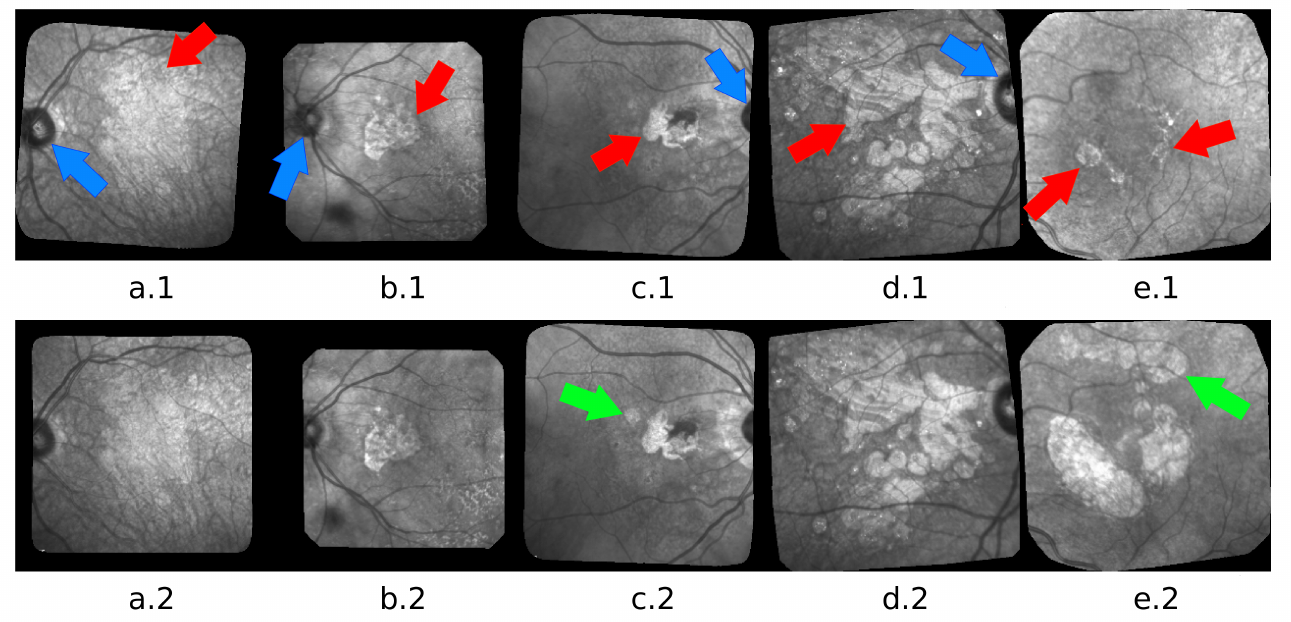
Figure 1. Five pairs of images: ( a ) advanced case with blur, low contrast and very indented GA boundary; ( b ) less advanced case with lesions at the center and around the optic disk; ( c ) a new lesion appears in the second image (green arrow); ( d ) GA with complex structure and texture; ( e ) example of progression of a GA during 6 years. A third GA appeared (green arrow). Arrows point to the GA (red) and to the optic disk